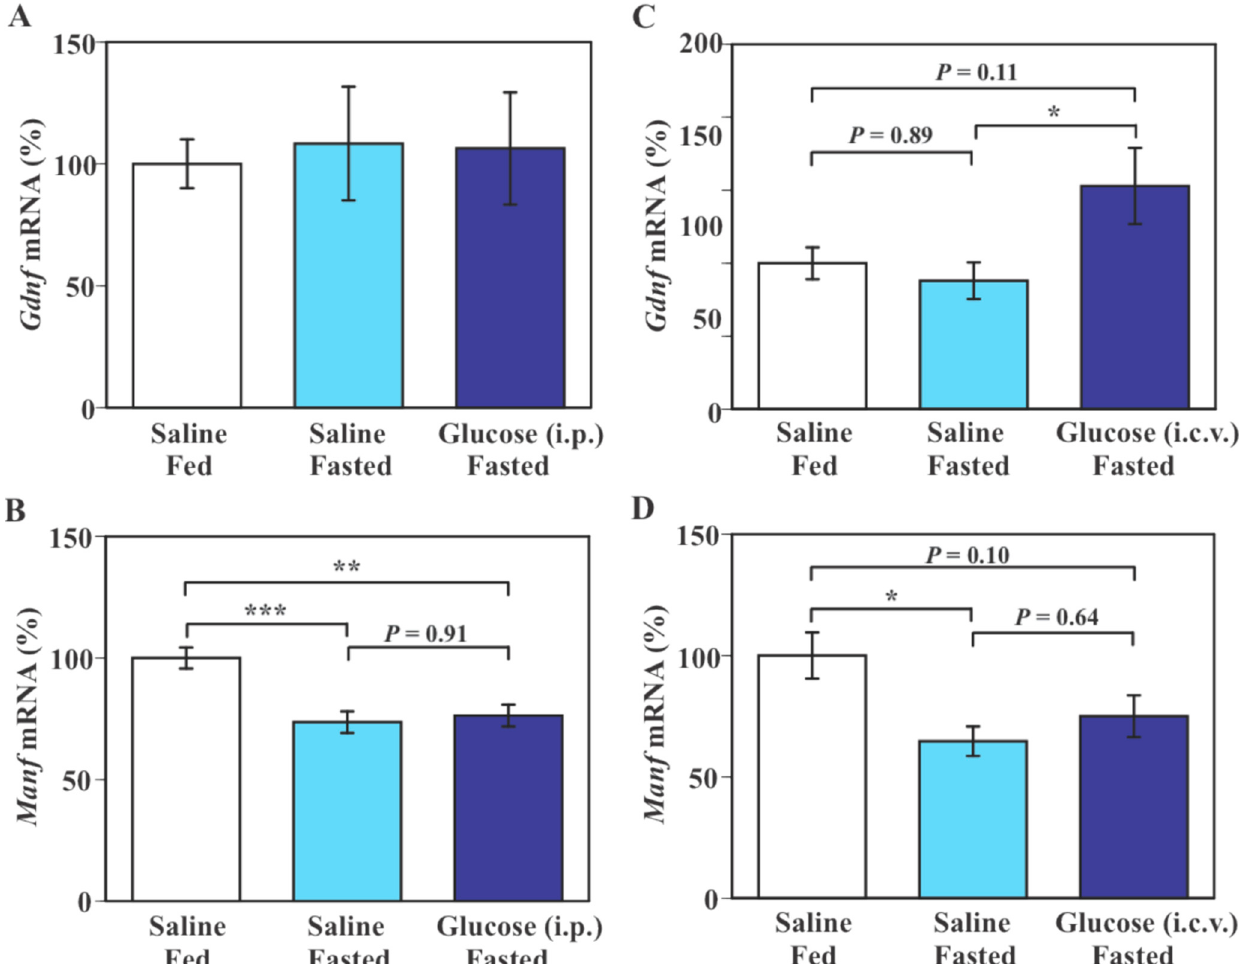
Figure 1C) without a significant change in Manf mRNA level in the hypothalamus (Figure 1D).